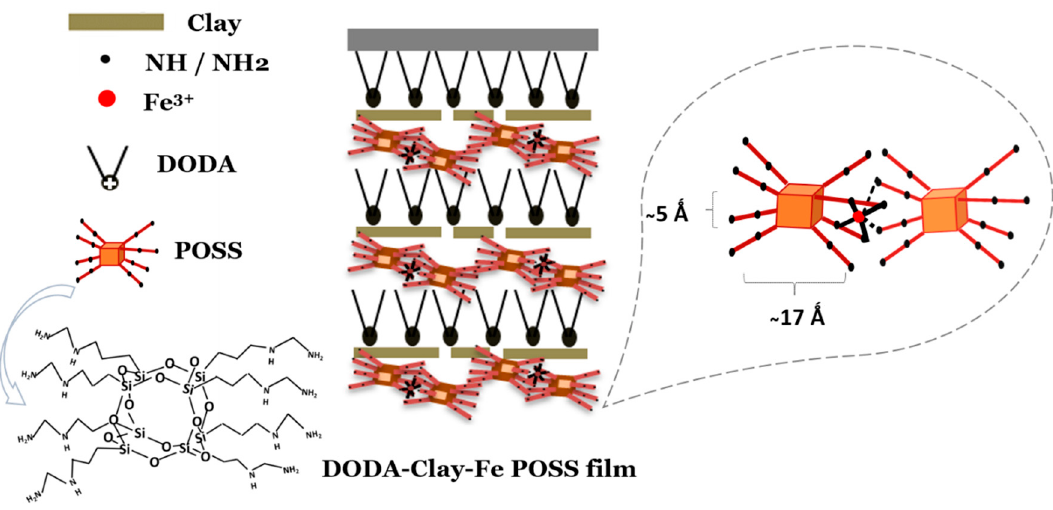
Scheme 2. Model of the arrangement of the POSS units in the DODA-clay-Fe/POSS films, which